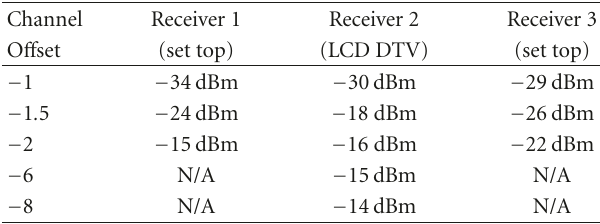
Table 1: Adjacent channel measurements.